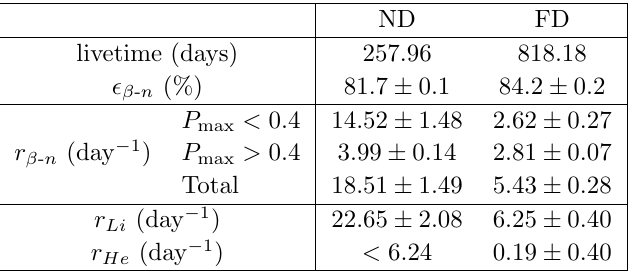
Table 1 . The livetime, (cid:12) - n rates along with their e(cid:14)ciencies (cid:15) (cid:12) - n , and the e(cid:14)ciency corrected total (cid:12) - n rate separated into the individual cosmogenic rates r c used to estimate the yields, production rates, and cross